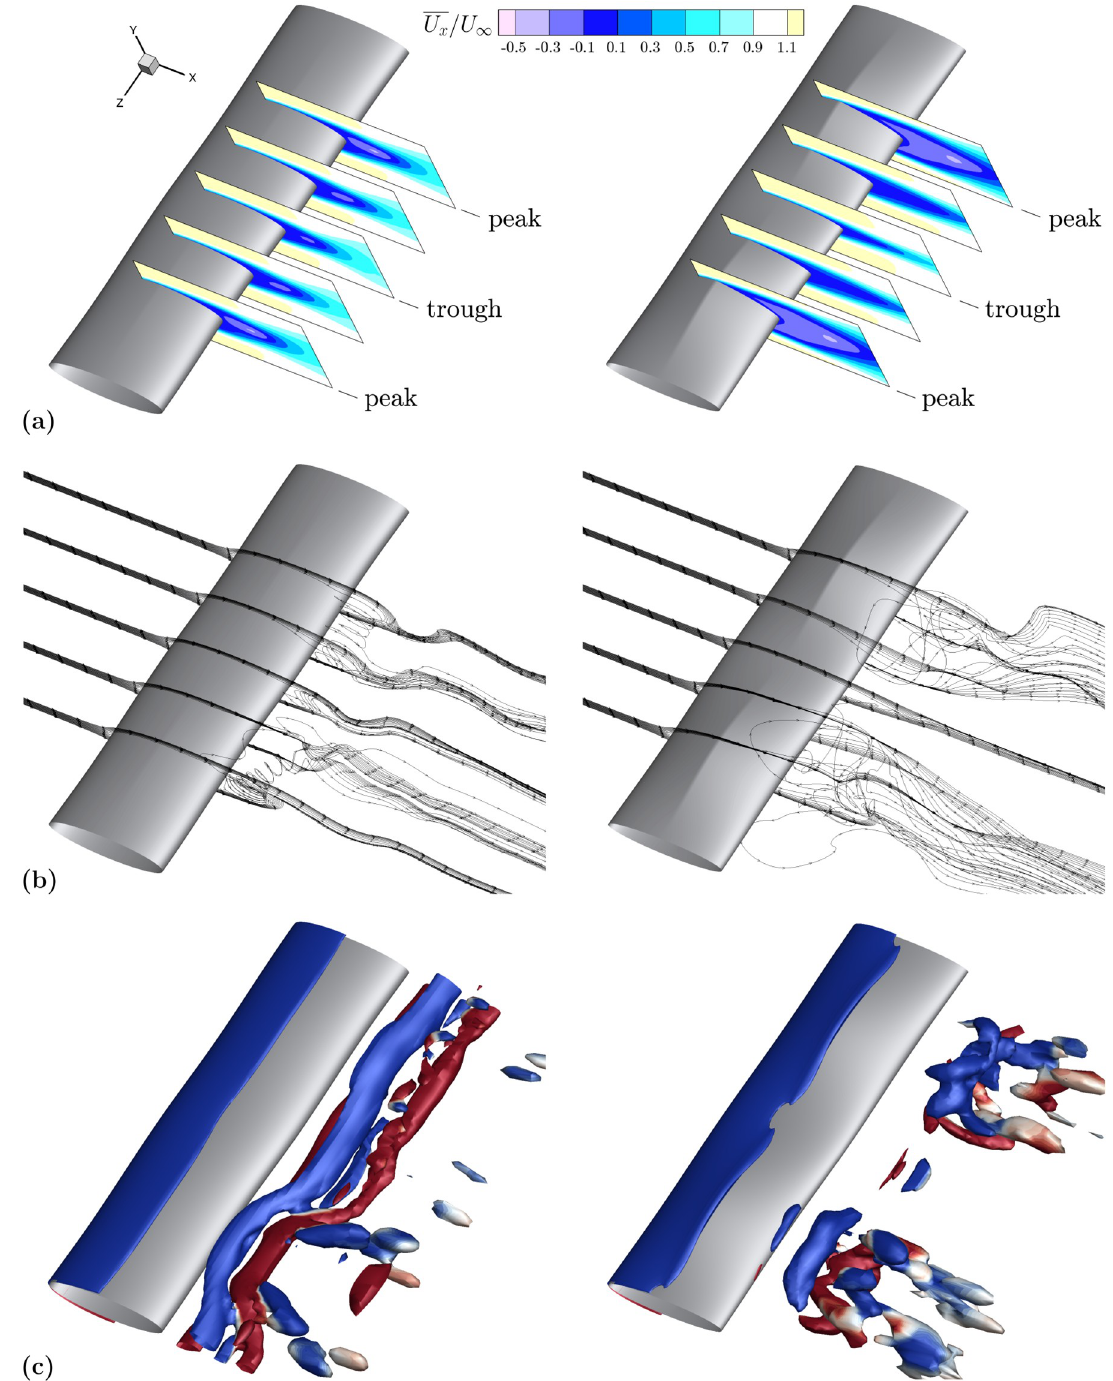
Fig 8. Flow comparison between low and high A geometries. EL1 (low A ) in the left column, EL2 (high A ) in the right column. (a) T T T The comparison of time-averaged streamwise velocity contours for low A T (left) and high A T (right) models shows considerable variation between recirculation length at peak and trough cross sections. Contours are shown at equally spaced spanwise locations where peak and trough correspond to A undulations. (b) Velocity streamlines at peak and trough spanwise locations denoted in 8a demonstrate more T spanwise transport for the high A T model. (c) Isosurfaces of nondimensional Q -criterion value 0.8, colored by positive (red) and negative (blue) z -vorticity. Isosurfaces display long, coherent structures at low A and breakup at high A . T T